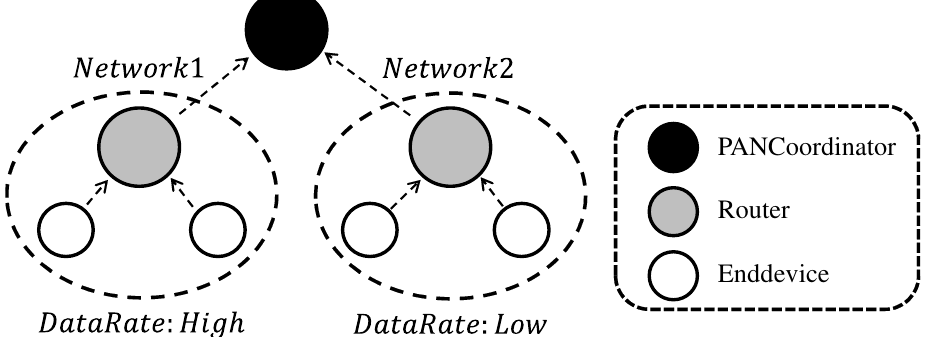
Figure 3. Example of a tree topology heterogeneous Wireless Sensor Networks